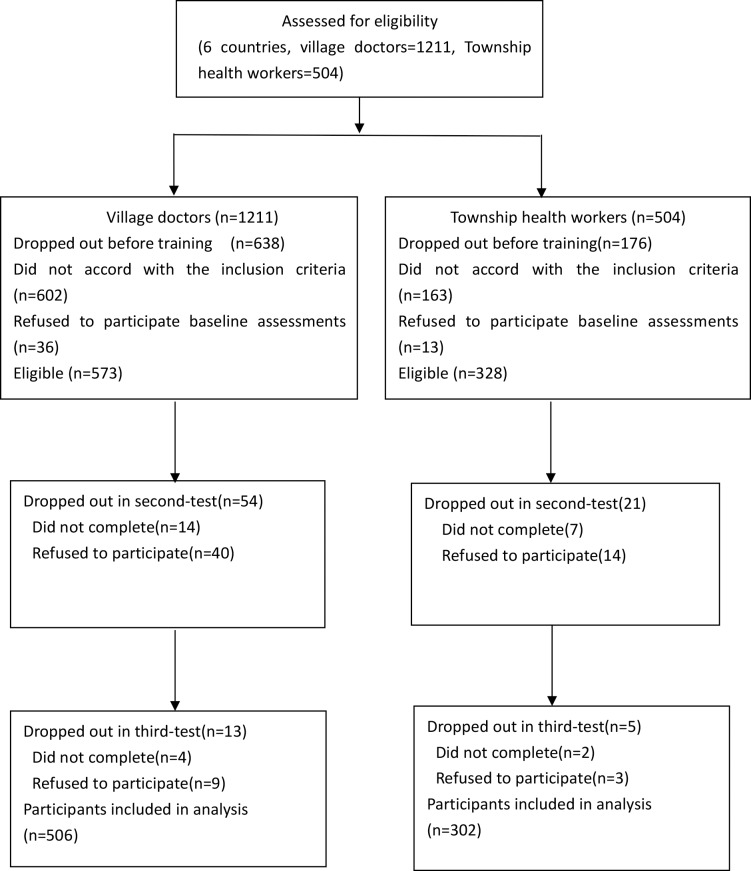
Research flow chart.